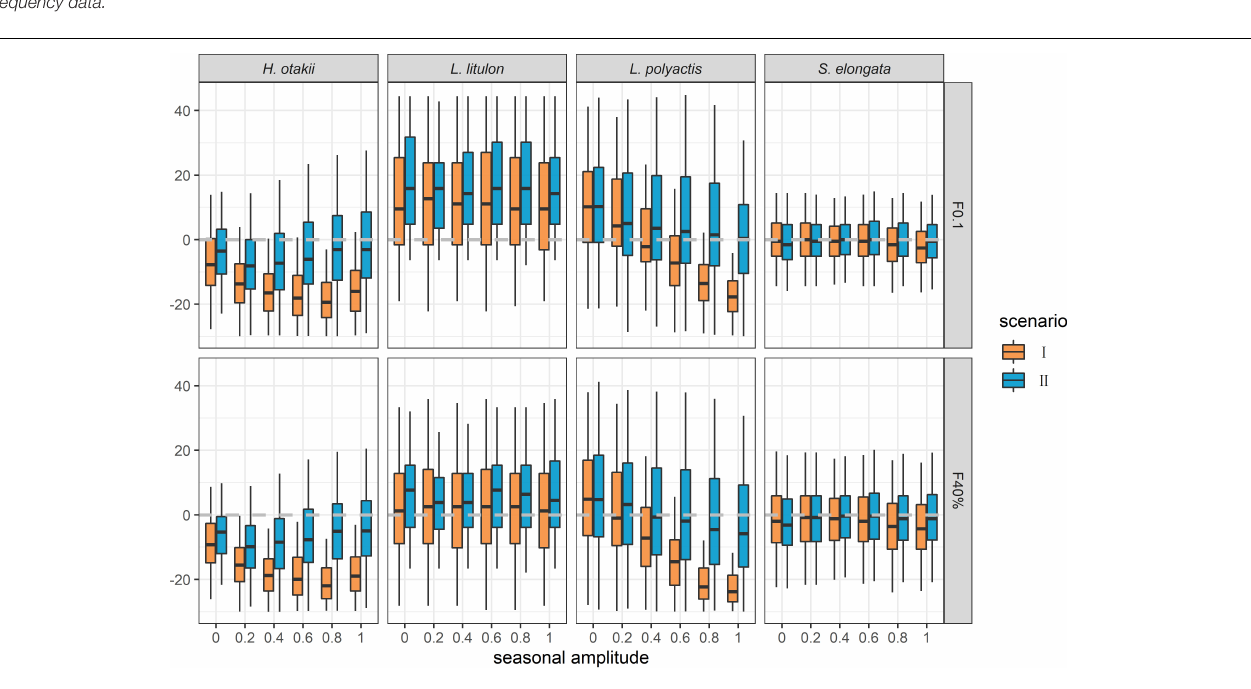
FIGURE 2 | Relative bias of estimated BRPs F 0 . 1 and F 40% for four case species in the case of ignoring seasonality (scenario I) and considering seasonality (scenario II) under different gradients of seasonal growth